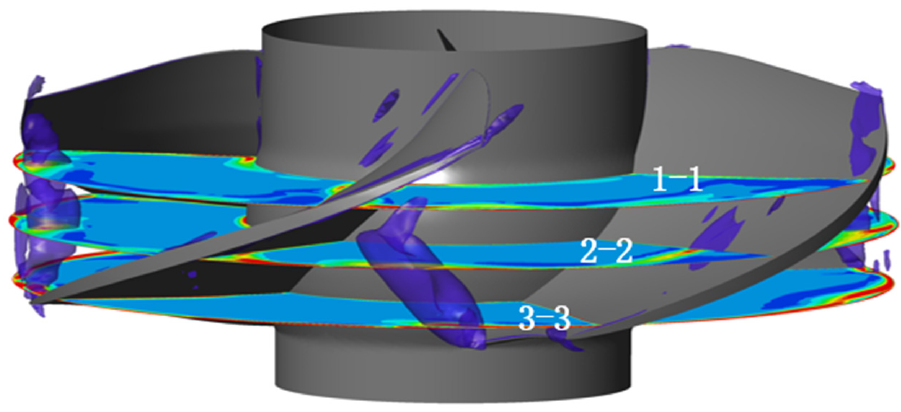
Figure 12. Schematic diagram of different sections.